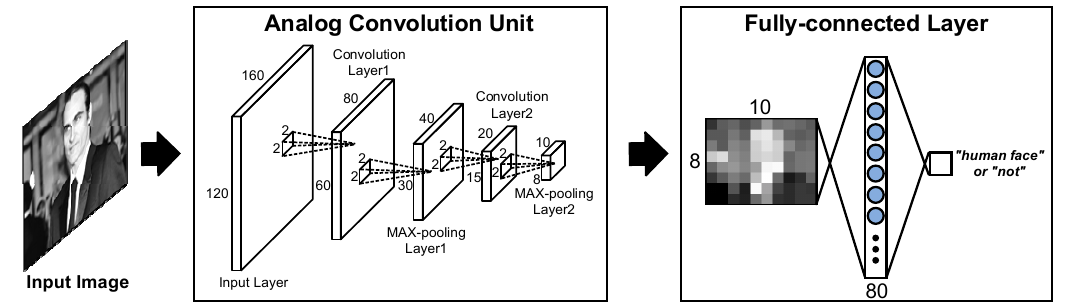
Figure 3. The proposed lightweight convolutional neural network (LWCNN) algorithm.